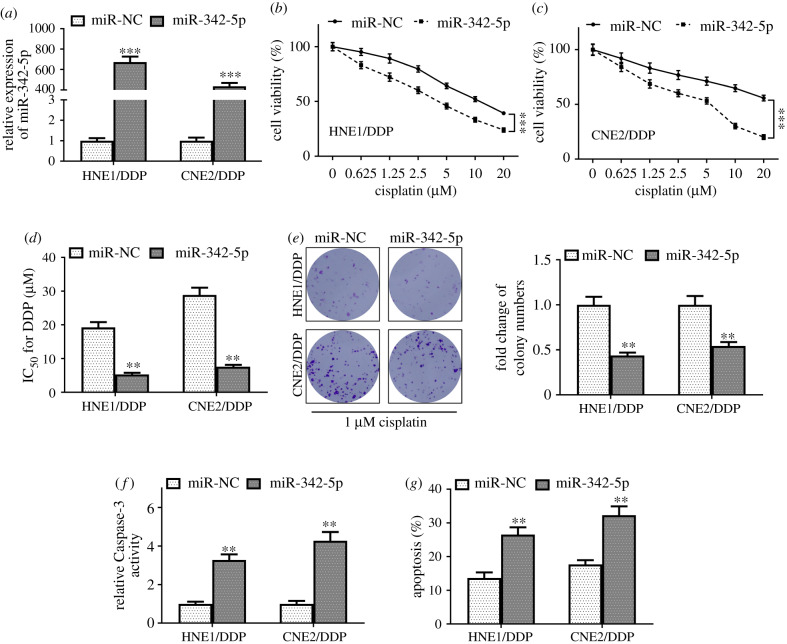
MiR-342-5p over-expression impairs resistance to cisplatin in NPC cells. (a) miR-342-5p expression in cisplatin-resistant NPC cells transfected with miR-342-5p mimics or miR-NC. (b,c) The cell viability of HNE1/DDP and CNE2/DDP cells transfected with miR-342-5p mimics or miR-NC. (d) Colony formation assay of HNE1/DDP and CNE2/DDP cells transfected with miR-342-5p mimics or miR-NC. (e) HNE1/DDP and CNE2/DDP cells transfected with miR-342-5p mimics or miR-NC were treated with various doses of cisplatin for 48 h to determine the IC50. (f,g) Apoptotic rate of HNE1/DDP and CNE2/DDP cells transfected with miR-342-5p mimics or miR-NC was measured by histone/DNA ELISA and Caspase-3 activity assay. The data show the mean ± s.d. **p < 0.01; ***p < 0.001.